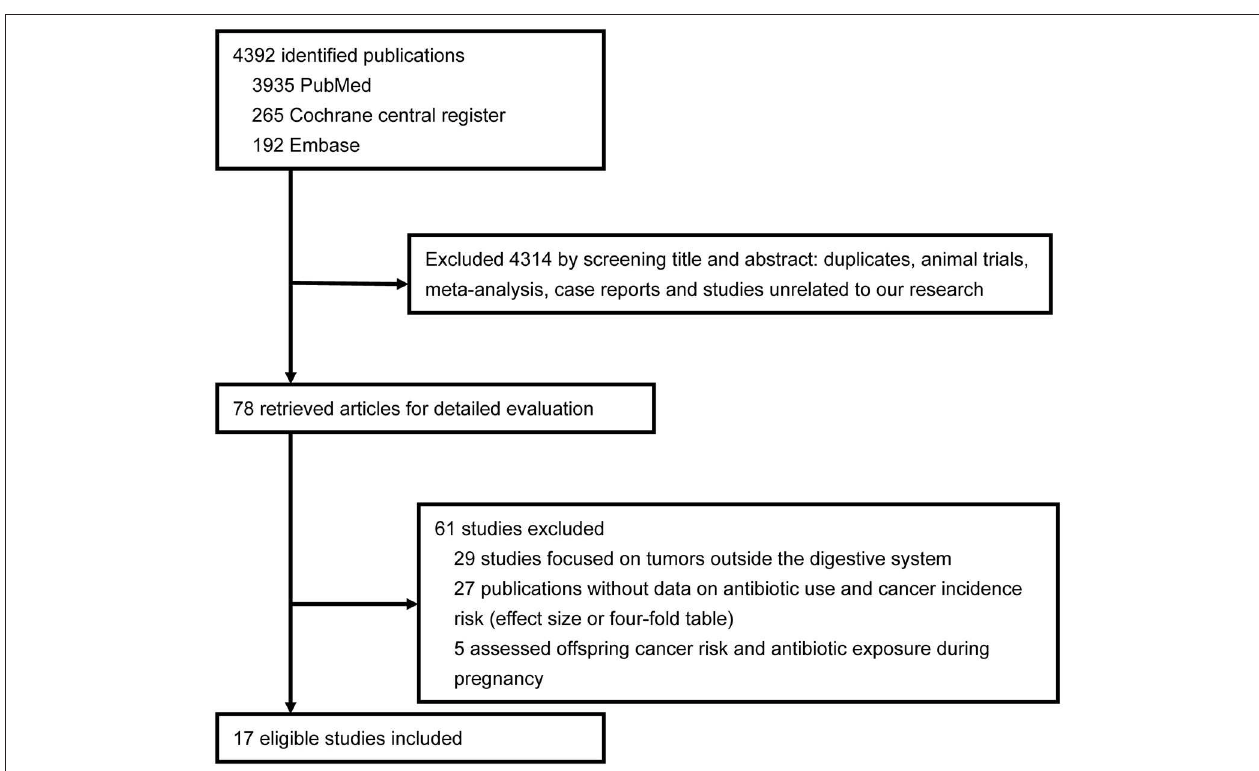
FIGURE 1 | Flowsheet of literature search and study